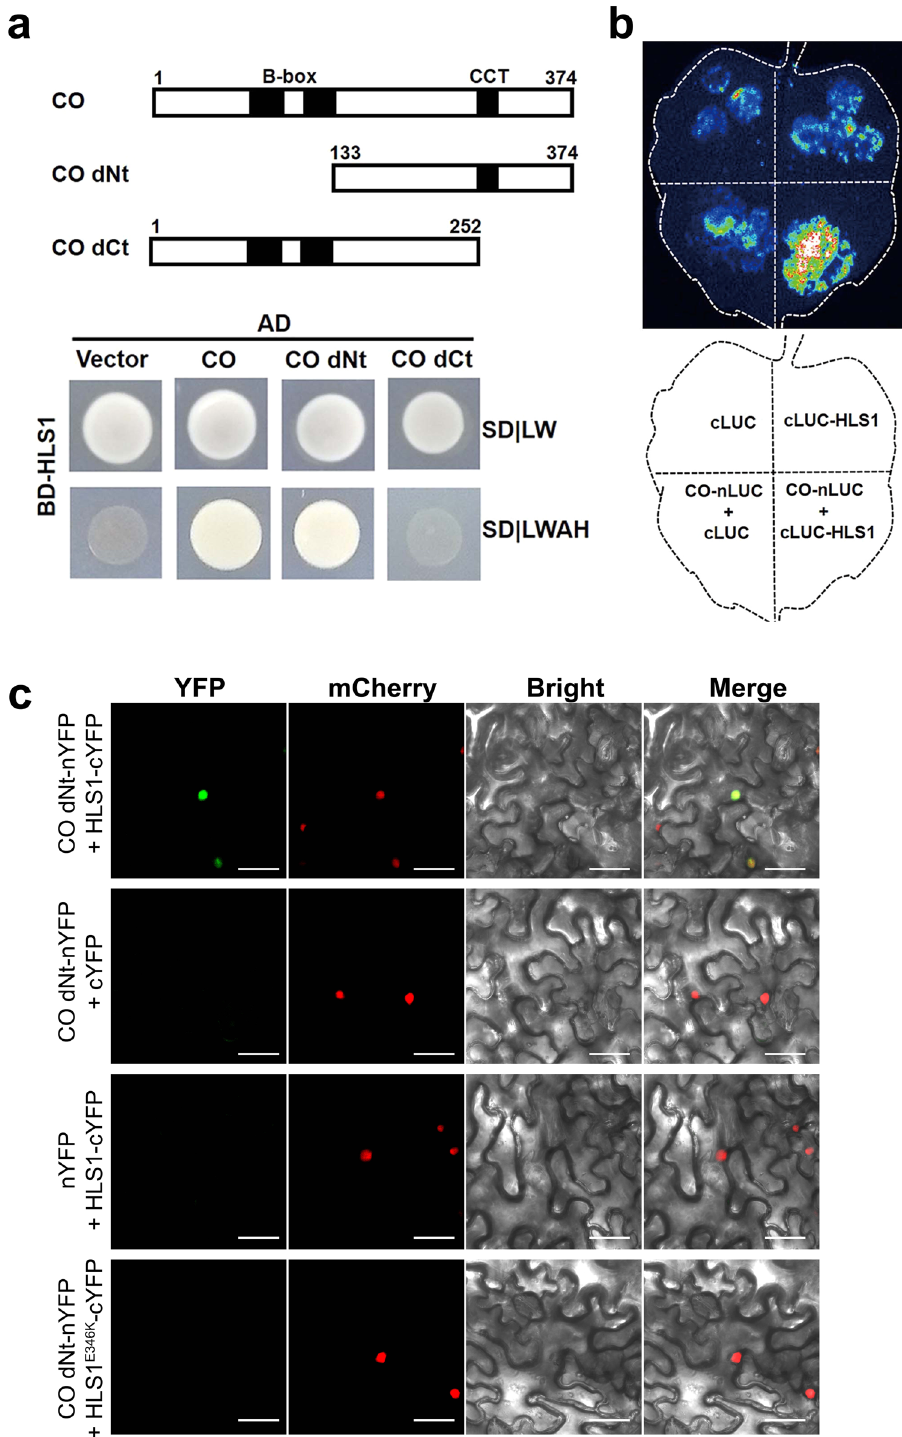
Fig. 4 HLS1 physically interacts with CO. a Yeast two-hybrid assays demonstrating that HLS1 interacts with CO. Truncated forms of CO are shown on the top. Numbers indicate the amino acid positions. b LCI assay showing that HLS interacts with CO in N. benthamiana leaves. A. tumefaciens cells harboring each construct were in fi ltrated into different areas of N. benthamiana leaves. After 2 – 4 days of in fi ltration, luciferin was sprayed onto the leaf surfaces and LUC activity was recorded. c BiFC assay showing HLS1-CO interactions. A. tumefaciens cells containing the indicated plasmids were co-in fi ltrated into N. benthamiana leaves for 2 days. YFP fl uorescence was monitored under a confocal laser-scanning microscope. The YFP signal (green) channel and the nuclear marker VirD2NLS-mCherry signal (red) channel were merged with bright fi eld images. Bars = 20 μ m. nYFP, N-terminal fragment of YFP; cYFP, C-terminal fragment of